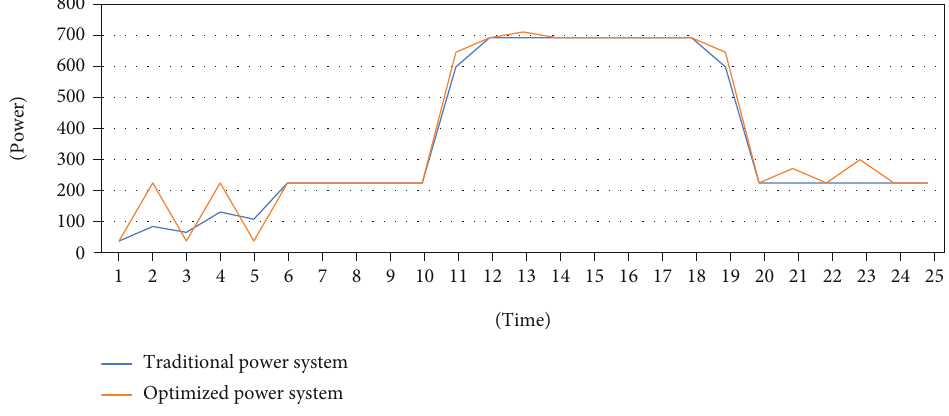
Figure 6: The power output of traditional and optimized power systems is compared.